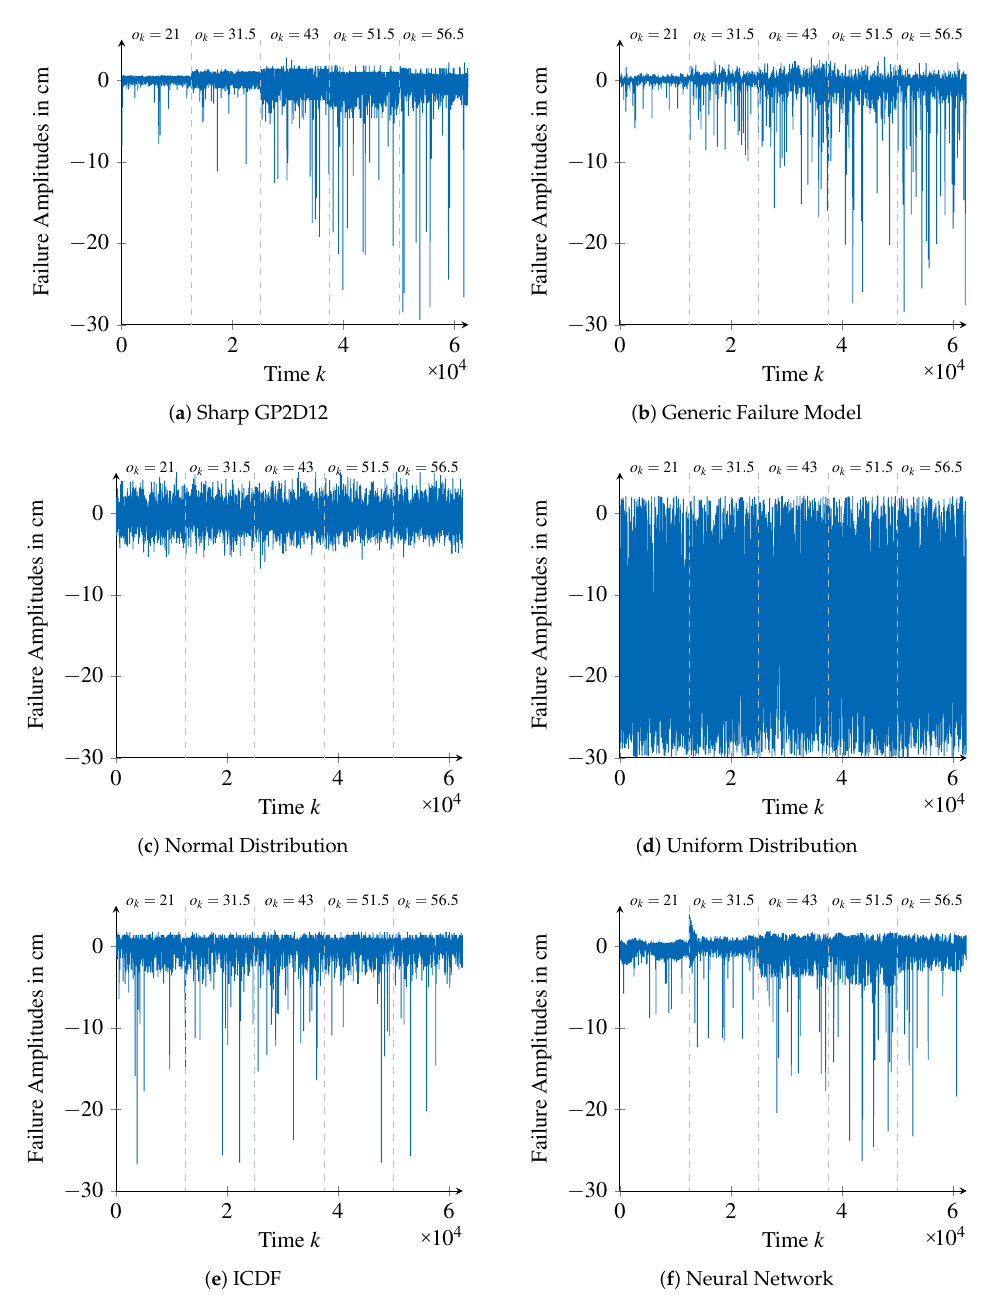
Figure 12. Failure amplitudes generated by different failure models to represent the failure characteristics of the Sharp GP2D12 infra-red distance